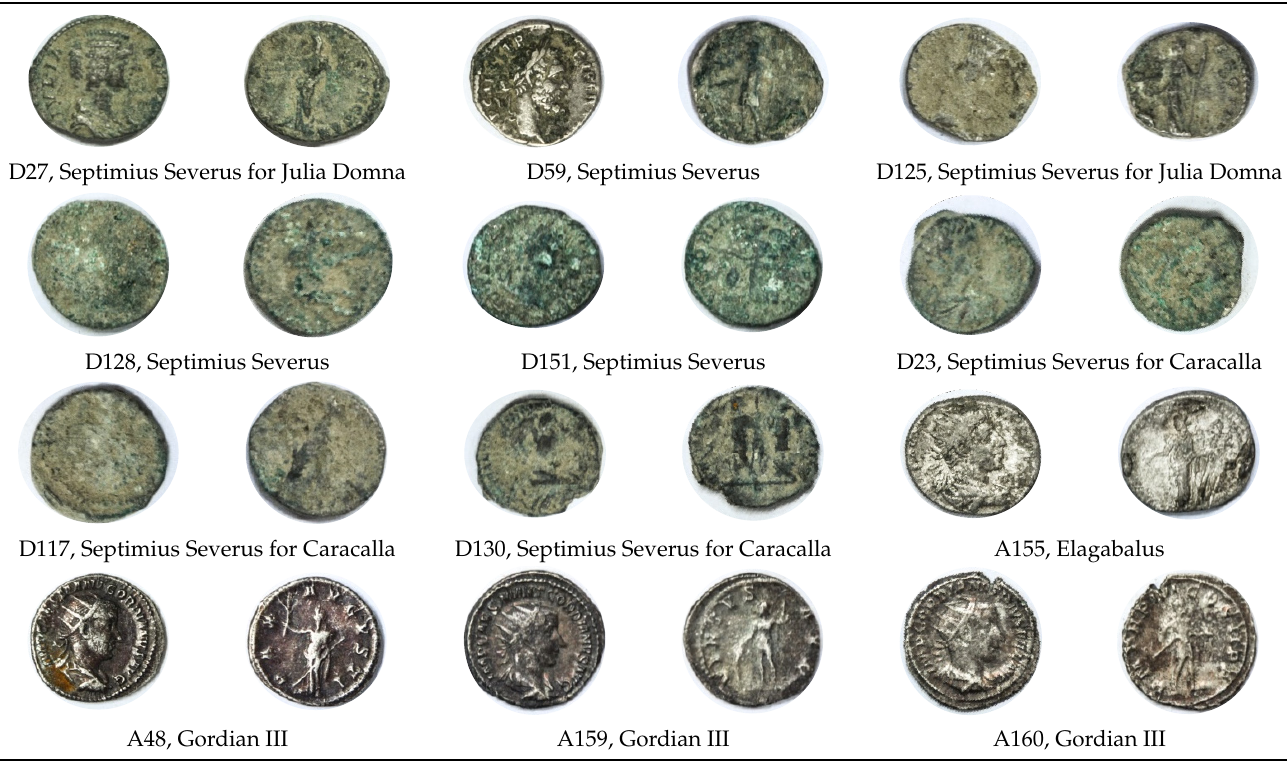
Table 2. Recto and verso of the 12 coins micro-sampled.